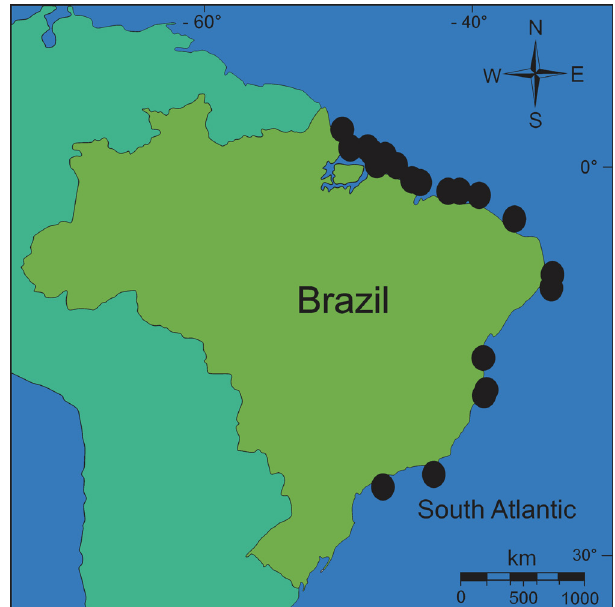
Figure 4. Distribution of Excorallana costata Lemos de Castro, 1960 for Brazilian waters.